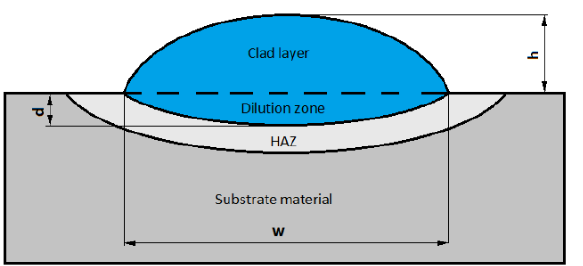
Figure 8. Diagram showing geometrical parameters of a CMT cladded single bead with operating parameters from Table 1: height (h), depth (d), width (w).